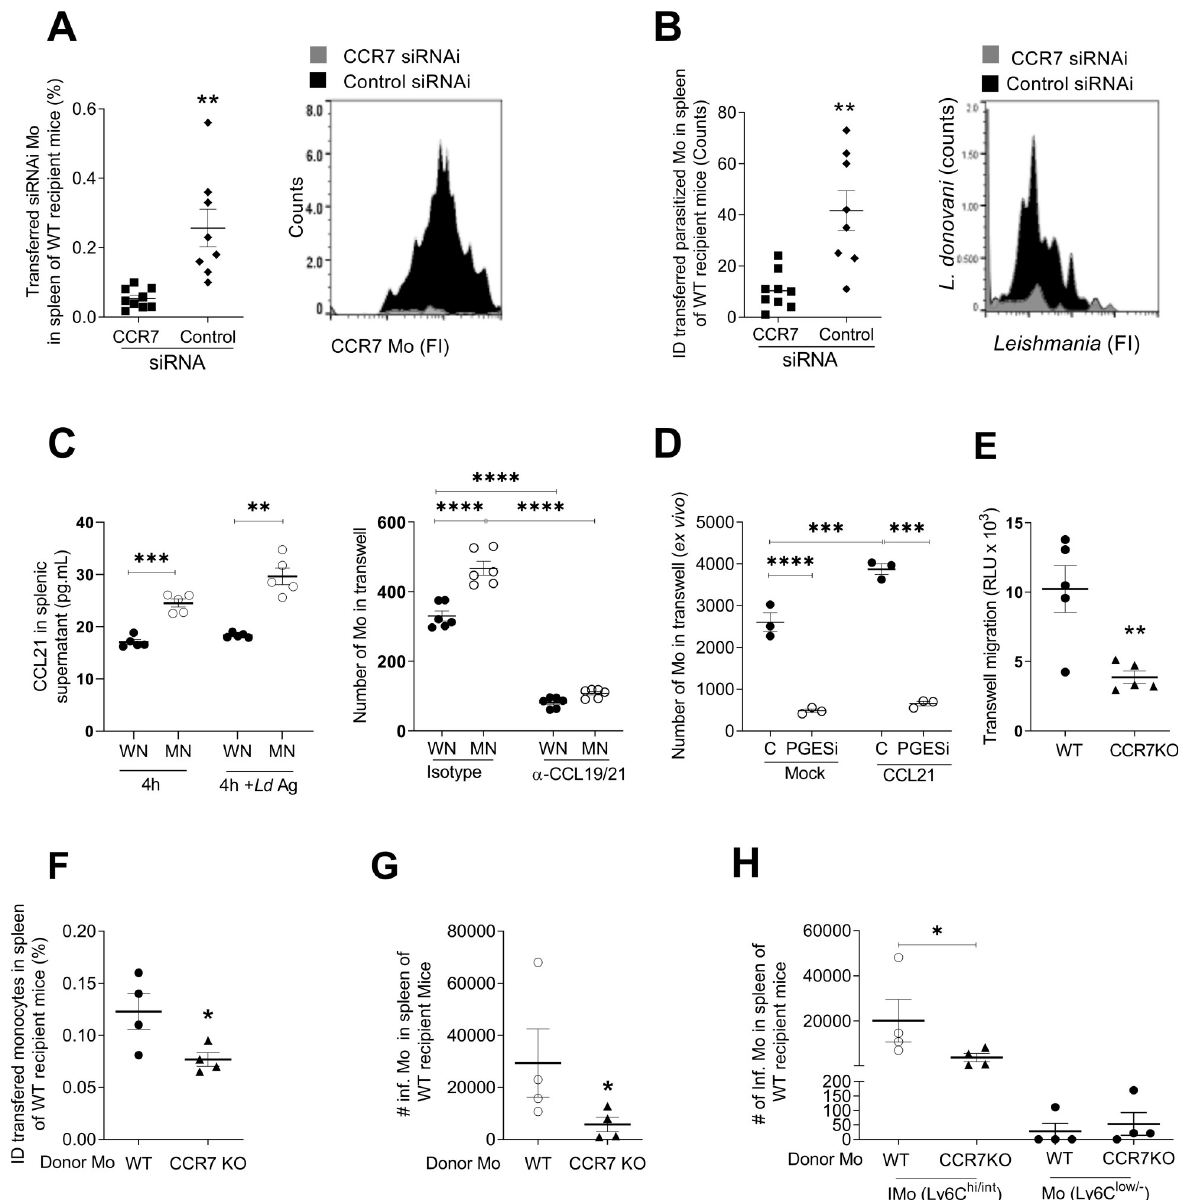
Fig 7. Monocyte-mediated, PGE 2 -driven L . donovani visceralization is dependent on CCR7 and its ligands in malnourished mice. A. Percent of skin-derived monocytes in the spleen of MN mice following intradermal infection with Far-Red-Cell Trace labeled L . do novani and ID transfer of CCR7-silenced PKH-67-labeled monocytes (CCR7 siRNA) or control PKH-26 labeled monocytes (control siRNA). Determined by flow cytometry 48 hrs after ID transfer and infection; shown as graph and representative histogram. �� p = 0.0014 (Unpaired t-test). N = 8–9 mice/group. B. Counts of fluorescent parasites (number of events) in control (siRNA control) or CCR7-deficient monocytes (CCR7 siRNA) in the spleen 24 hrs after ID infection and monocyte transfer in MN mice. Determined by flow cytometry with gating on the population of labeled-transferred monocytes. Shown as graph and representative histogram. �� p = 0.0011 (Unpaired t-test). N = 8–9 mice per group. C. Left panel: Levels of CCL21 released to supernatants of spleen cell cultures from WN or MN mice over 4 hrs culture with or without exposure to L . donovani antigen (Ld Ag). N = 5 mice per group. Right panel: migration of monocytes in response to splenic chemokines determined in a transwell assay with 10 6 bone marrow-derived monocytes from control mice in the upper chamber and 24-hr culture supernatants from 10 6 spleen cells from L . donovani infected well-nourished (WN) or malnourished (MN) mice in the lower chamber. Monocyte migration to the lower chamber was determined by cell counting and flow cytometry after 16h in the presence of neutralizing anti-CCL19/21 or isotype control antibody. ���� p < 0.0001; ��� p = 0.0002; �� p < 0.001 (One-way Anova). N = 6 mice per group. D. Ex vivo transwell migration of bone marrow-derived monocytes from L . donovani -infected malnourished mice treated with DMSO (C) or prostaglandin E synthase inhibitor (PGESi) (5 mg/kg/IP/day, 48h before infection and 5 μ M ex vivo ), in response to buffer alone (Mock) or 300 ng/mL CCL21. Monocyte migration to the lower chamber was determined after 16h of culture by luminometry. Pooled cells from N = 5 mice per group (triplicate). ���� p < 0.0001; ��� p = 0.0006 (One-way Anova). E. Transwell assay